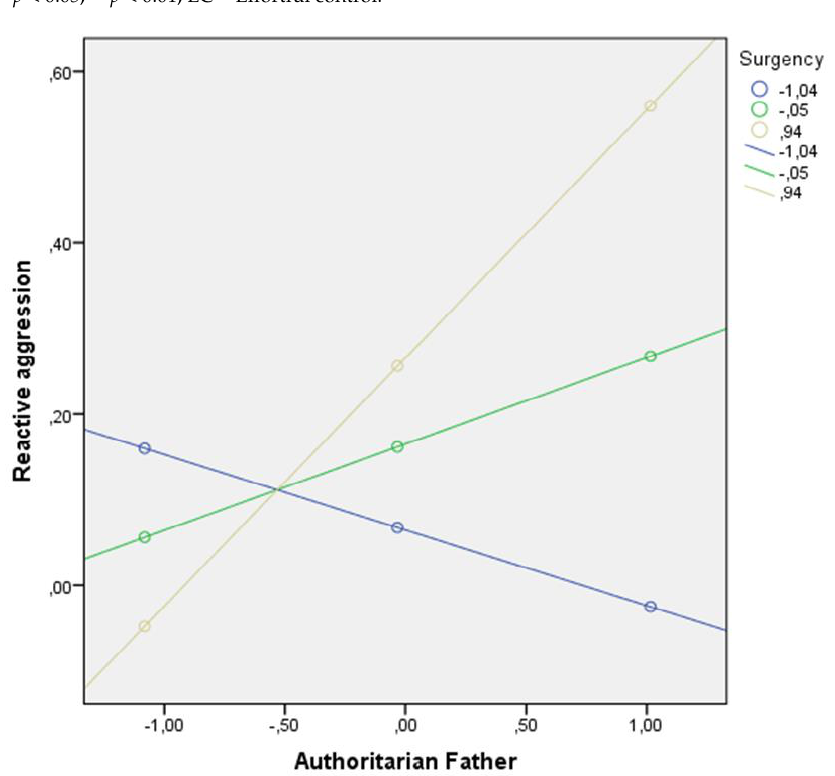
Figure 1. Interaction between surgency and the father’s authoritarian parenting style in relation to reactive aggression in boys.